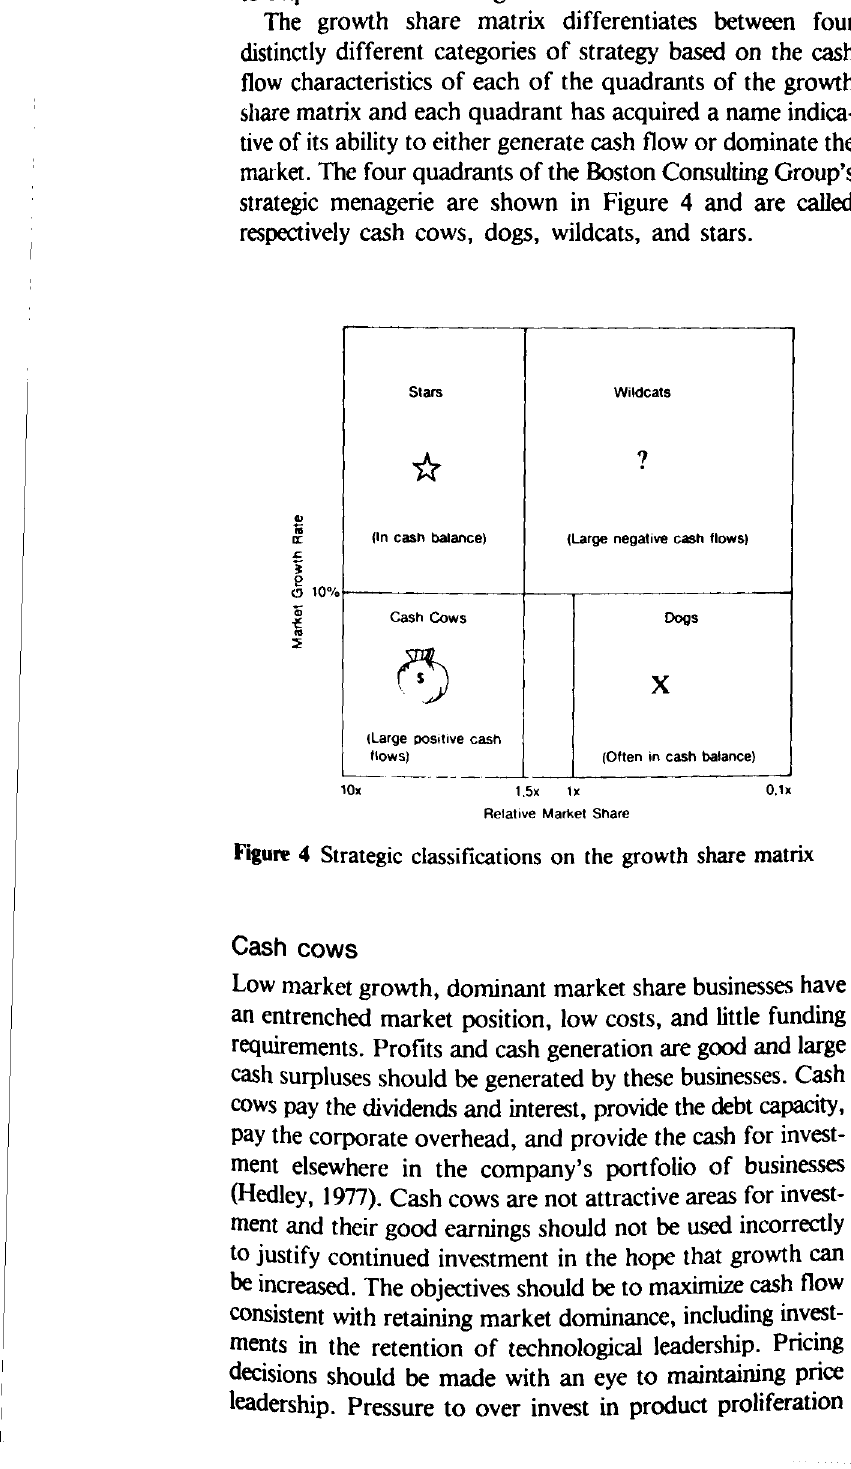
Figure 4 Strategic classifications on the growth share matrix